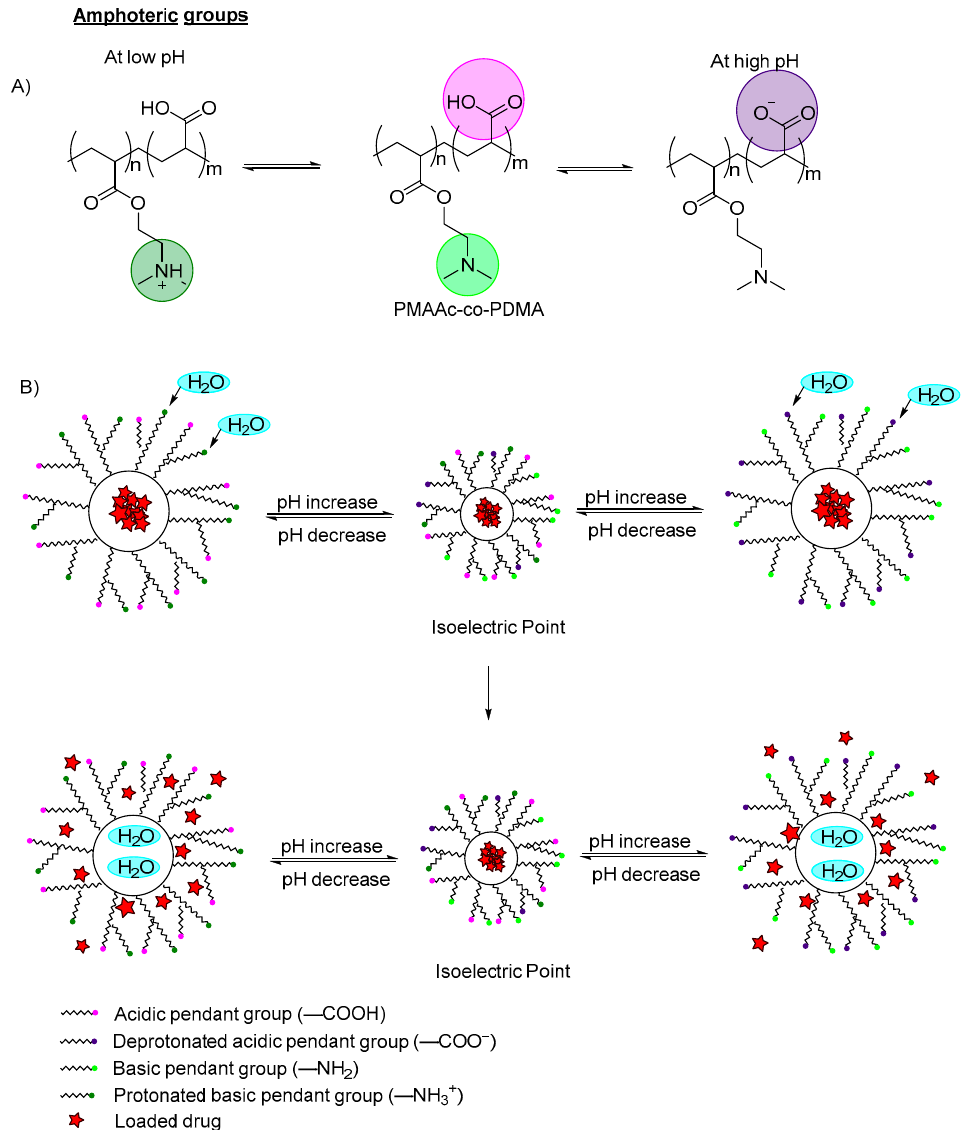
Figure 4. ( A ) An example of deprotonation (at high pH) and protonation (at low pH) of an amphoteric copolymer. The carboxylic groups are labeled in purple, the amine groups labeled in green; ( B ) An example of a polymer containing zwitterionic ions (both carboxylic group and amino group) with model drug loaded. At the isoelectric point, the acidic pendant group, basic pendant group, cations and anions remain in equilibrium. When the pH is decreased, the amino groups are protonated, and the polymer networks swell due to the electrostatic repulsion between the neighboring positive groups, which induces water diffusion into the polymer network, releasing the incorporated